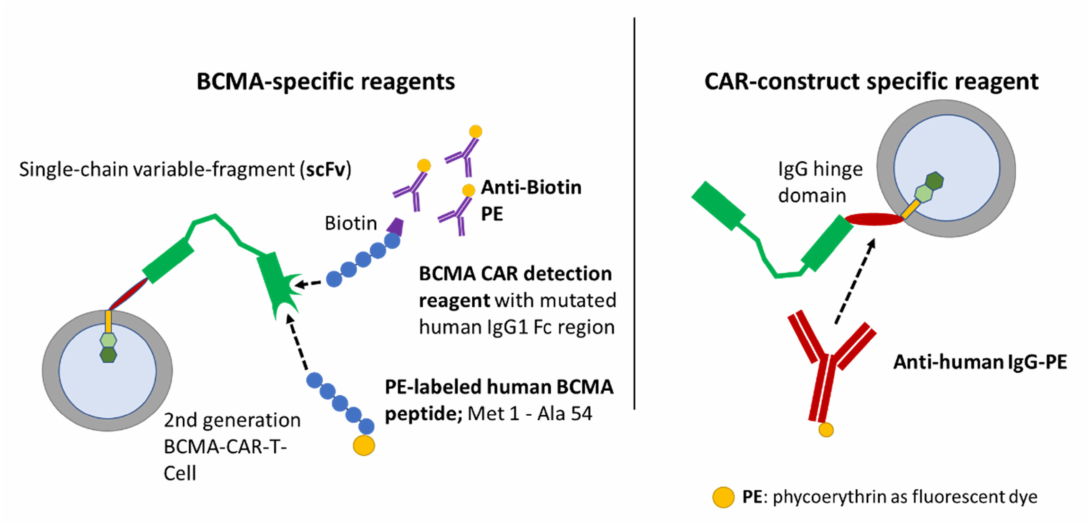
Figure 1. Binding mechanisms of flow-cytometric detection reagents. The left panel depicts BCMA- CAR-specific reagents. The right panel depicts a reagent which can be used for several different CAR constructs comprising a CH2-CH3-hinge region. The BCMA-detection reagent (Miltenyi Biotec) consists of a two-step staining mechanism: the first reagent is a fusion protein of the human BCMA extracellular domain and a mutated human IgG1 Fc region, therefore it does not require preliminary Fc blockage [17]. Moreover, this antigen-based detection reagent is conjugated to biotin. Therefore, the second component of the detection reagent is a monoclonal antibody directed against biotin and labeled with phycoerythrin (PE). Another specific staining approach employs a PE-labeled, truncated human BCMA protein/long peptide (ACRObiosystems), which consists of the BCMA protein amino-acid residues Met1 to Ala54. It is directly conjugated to a PE fluorochrome and therefore only requires a single staining step. The CAR-construct-specific reagent on the right can only bind to CAR constructs, which consist of a CH2-CH3-hinge region. The reagent consists of polyclonal-antibody serum directly conjugated to a PE